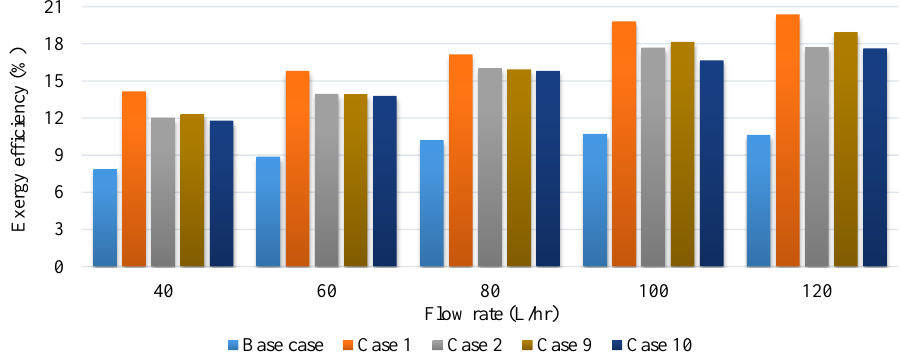
Figure 3. The exergy efficiency of Case 1, Case 2, Case 9, and Case 10 for different flow rates at the inlet temperature of 20 °C.